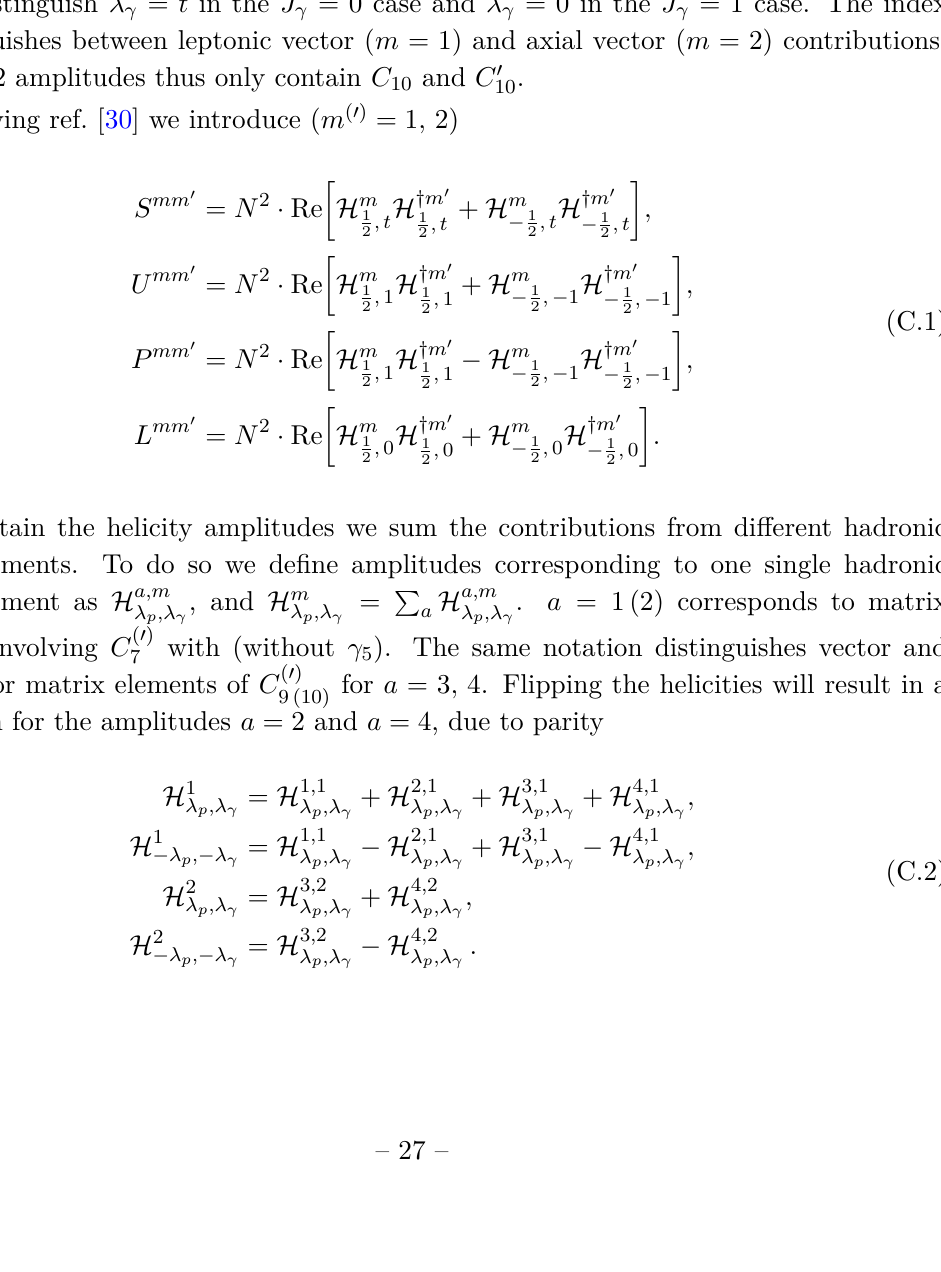
respectively. λ further distinguish λ